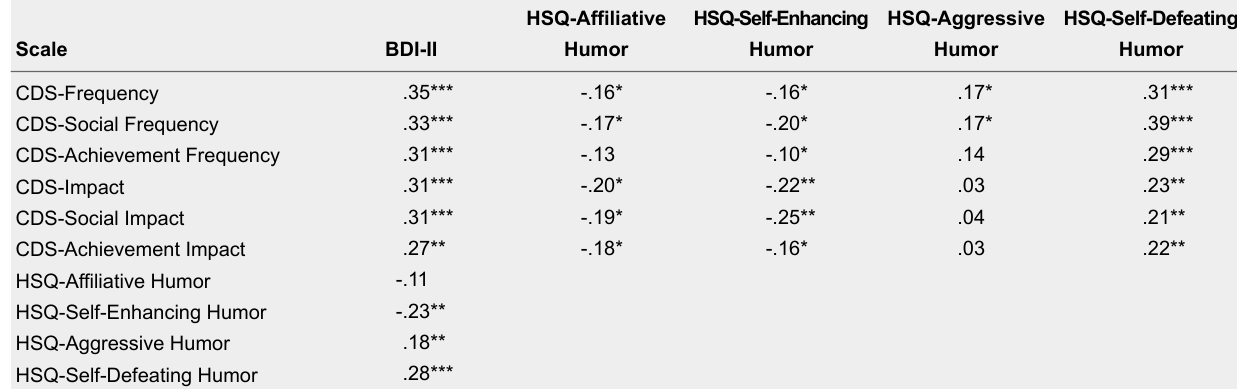
Pearson Correlation Coefficients Between Depressive Symptoms, Cognitive Distortions, and Humor Styles